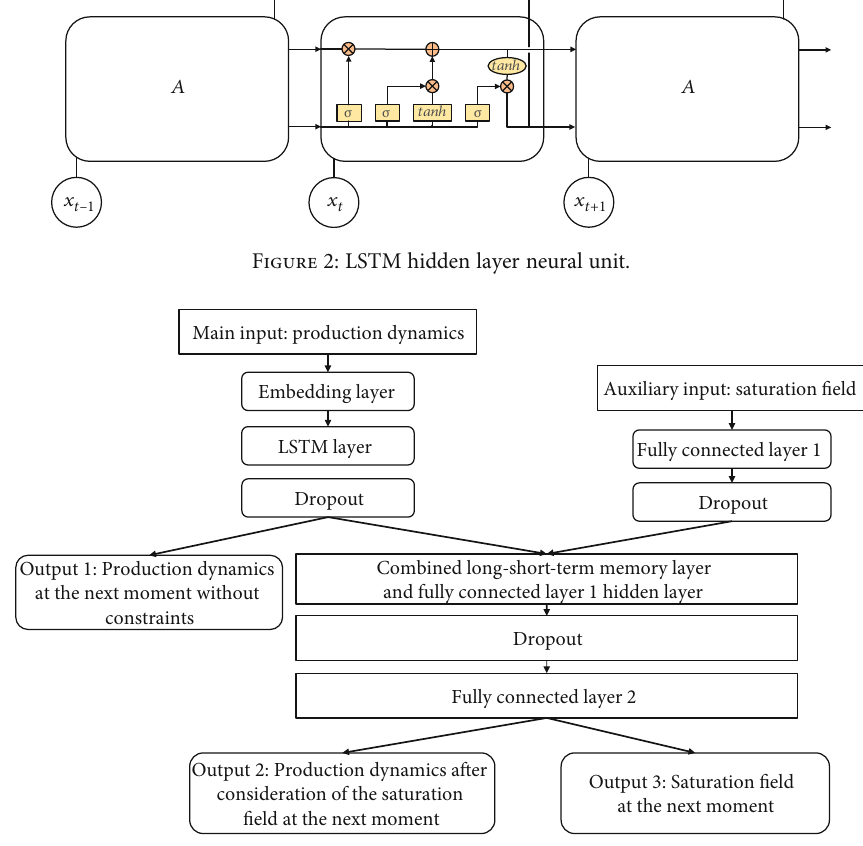
Figure 3: Schematic diagram of the deep neural network